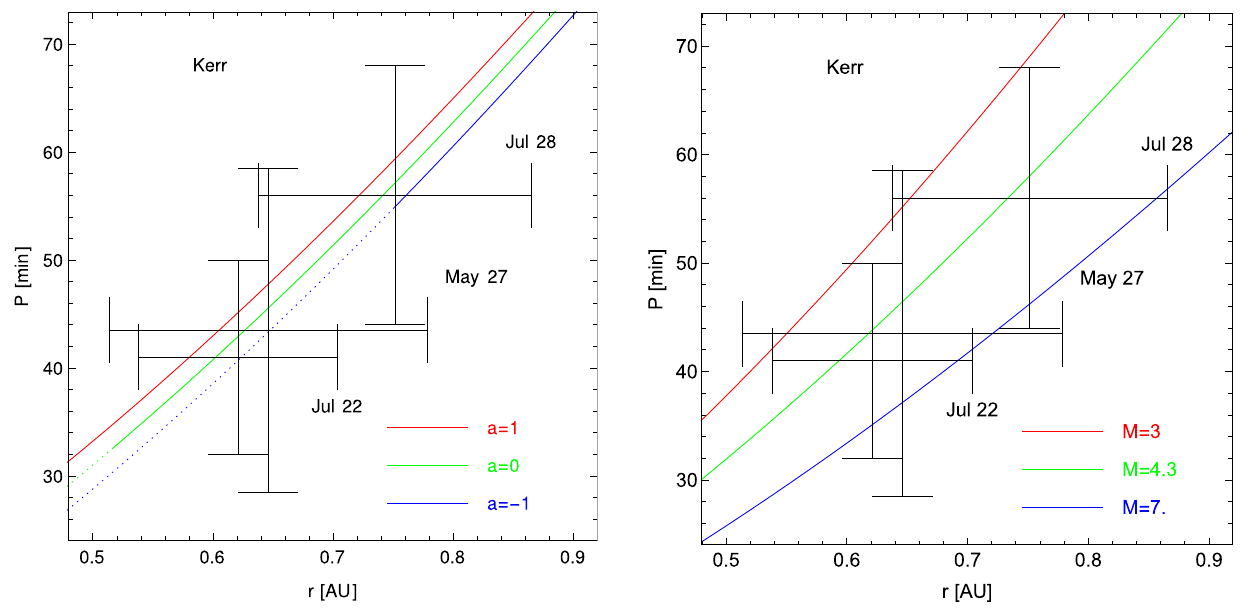
Fig. 1 Left: The relation between orbital period-radius, and position of three flares proposed by GRAVITY on July 22, May 27, and July 28, 2018 fitted with circular orbits of a neutral hot-spot in the background of Kerr BH with mass M = 4 . 3 × 10 6 M (cid:3) . The green curve is plotted for vanishing spin ( a = 0) that corresponds to the Schwarzschild BH, while red and blue curves correspond to the co-rotating and counter- rotating orbits of hot-spot orbiting Kerr BH with spin a = ± 1, fitting